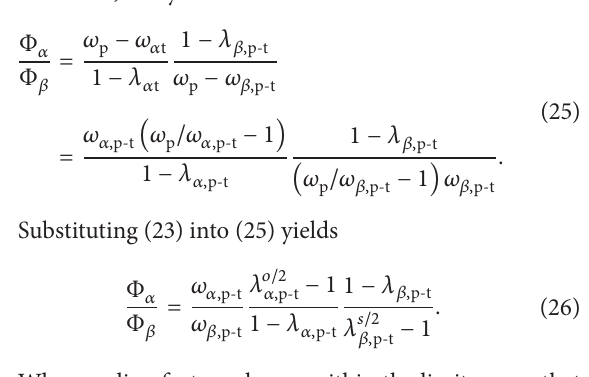
Figure 2: The thin walled annular